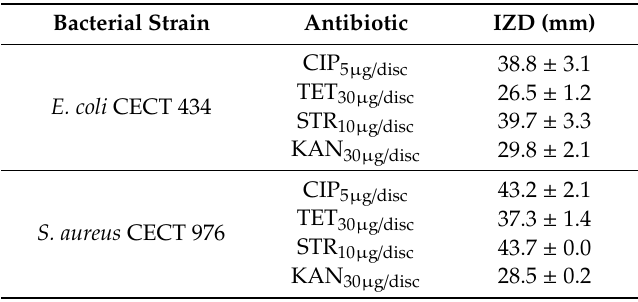
Table 2. IZD (Inhibition zone diameters), in mm, promoted by CIP (ciprofloxacin), TET (tetracycline), STR (streptomycin) and KAN (kanamycin). Data are expressed as mean ± SD of three independent assays. The two antibiotics with lowest IZD values per strain are presented in bold.